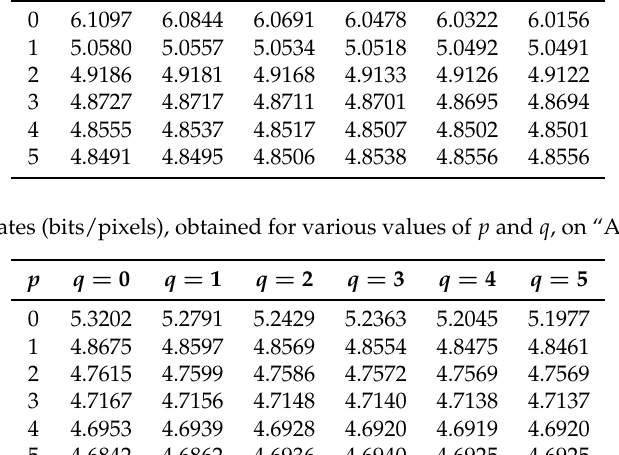
Table A9. Bit rates (bits/pixels), obtained for various values of p and q , on “AAMU Scene-1”. p q = 0 q = 1 q = 2 q = 3 q = 4 q = 5 0